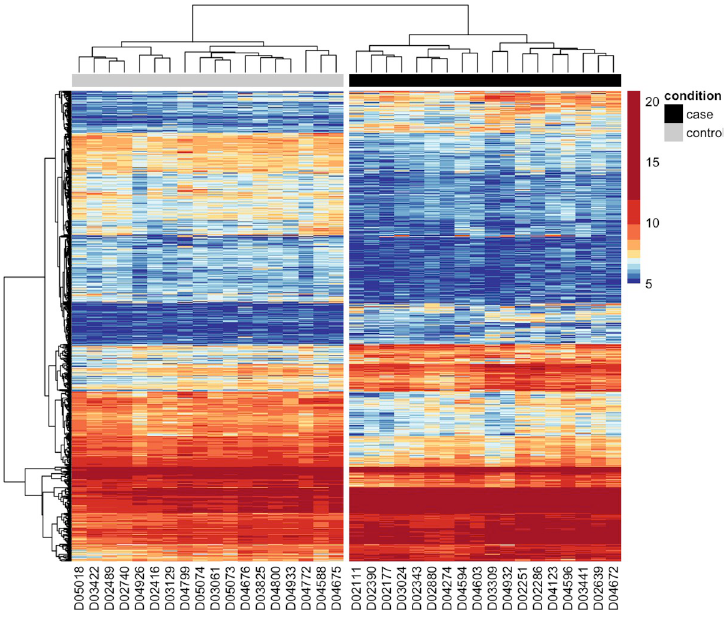
Fig 1. Heatmap of differentially expressed genes in dogs with IMHA vs. healthy dogs. Expression of 966 DEGs in dogs with IMHA (right) and healthy dogs (left). Gene expression values are based upon VST-transformed read counts in each dog, with higher values shown in red and lower values shown in